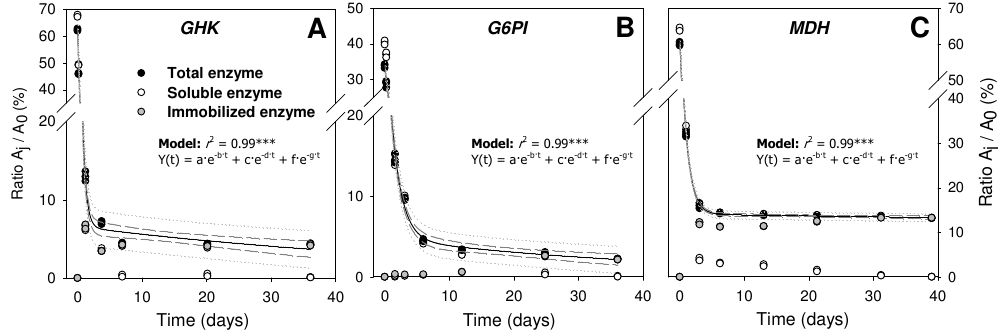
Fig. 2. Activity of three specific enzymes involved in glycolysis and the Krebs cycle following their incorporation in the non-irradiated-soil from Theix. Enzyme activity along time ( A j ) is expressed as % of the initial activity of enzymatic solution ( A 0 ) applied to the soil. The activities of total (dark circles), soluble (white circles) and immobilised enzymes (grey circles) are distinguished. Full, dashed and dotted lines represent the fit of the kinetic model on total enzyme activity, its confidence and predictive error intervals at 5% P-level, respectively. (A) G6PI: glucose-6-phosphate isomerase; (B) GHK: glucose hexokinase; (C) MDH: malate